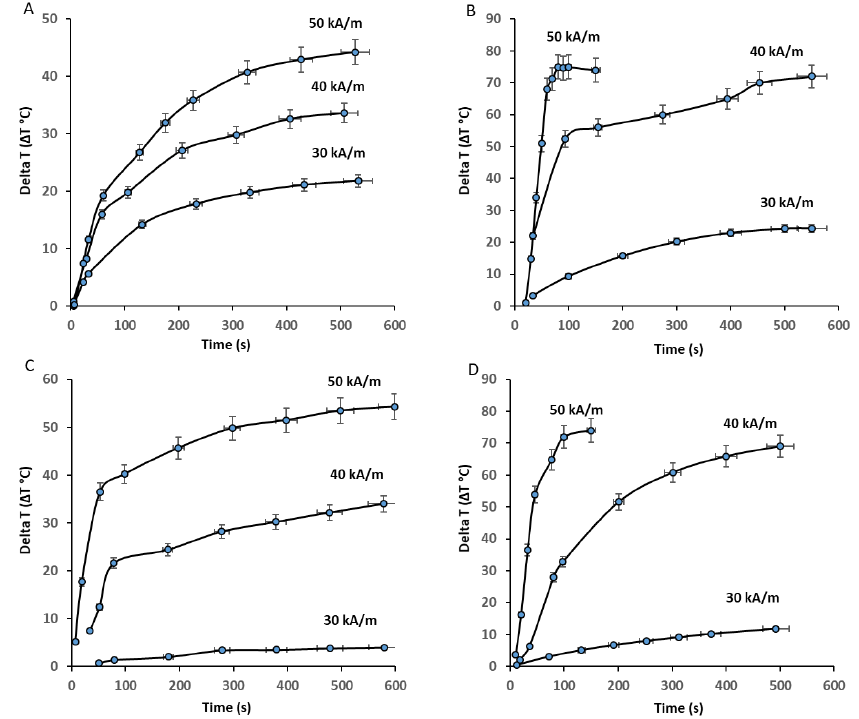
Figure 7. Heating profiles of CF-MNPs ((8 mg/mL) ( A ), (25 mg/mL) ( B )) and ZCF-MNPs ((8 mg/mL) ( C ), (25 mg / mL) ( D )) with magnetic field strengths (30, 40, or 50 kA / m) at a frequency of 97 kHz.